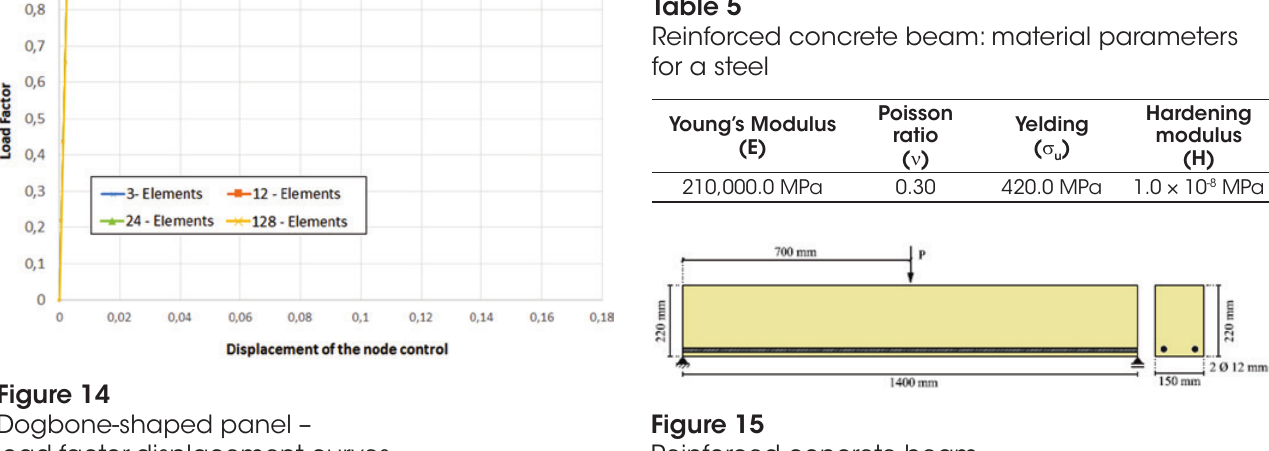
Reinforced concrete